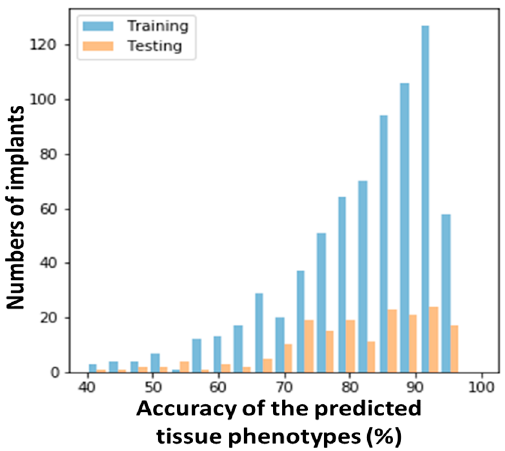
Figure 3. Histogram analysis of the accuracy on the 35th day after the day-by-day continuous prediction for all the implants in the dataset.